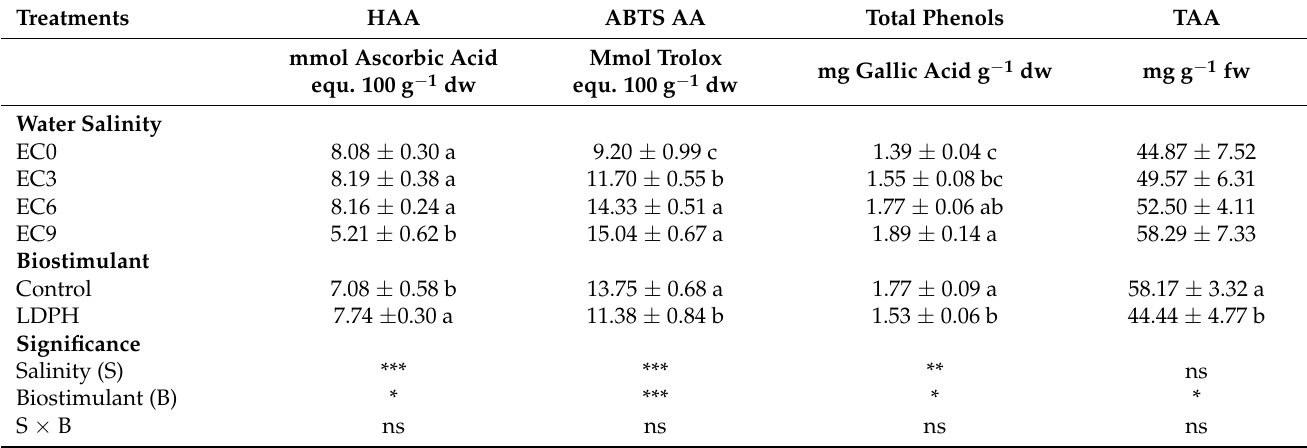
Table 5. Effects of irrigation water salinity and biostimulant application on hydrophilic and ABTS antioxidant activity (HAA and ABTS AA, respectively), total phenols, and total ascorbic acid (TAA) of spinach